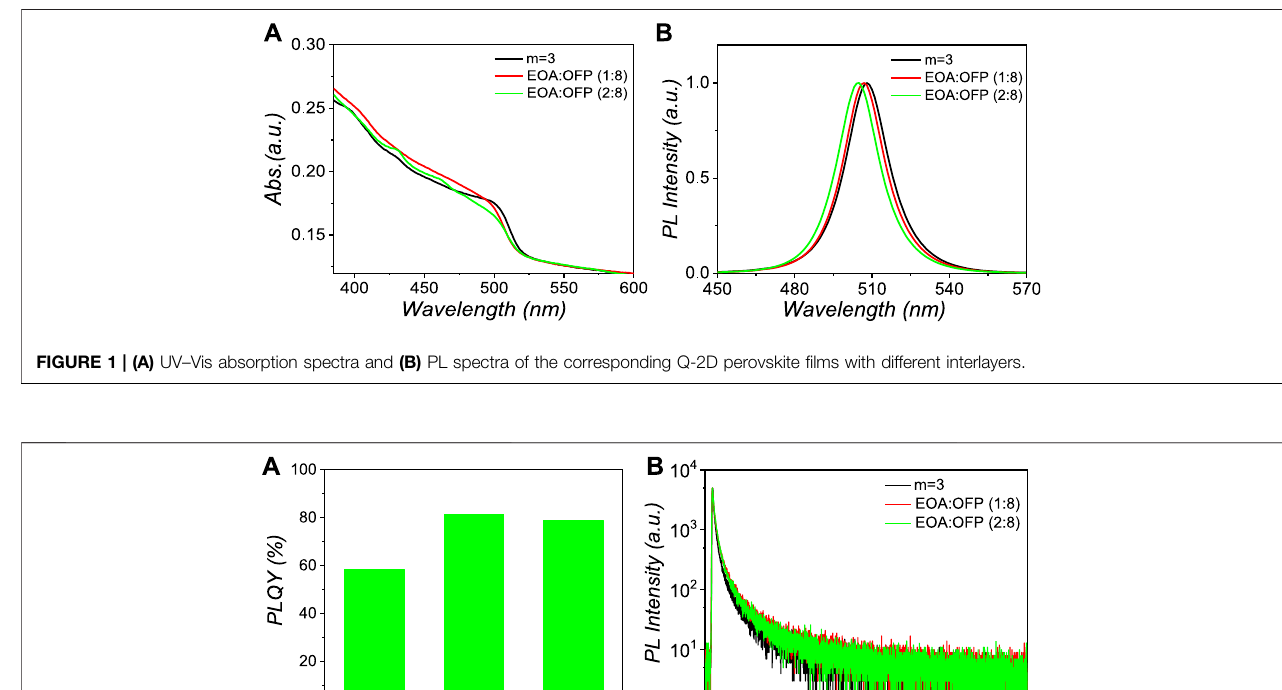
( Supplementary Figure S5 ). The diffraction pattern of CsPbBr 3 (stand PDF# 18-0364) was also included for comparison. The 2 θ diffraction peaks at 15.24 ° and 30.71 ° are